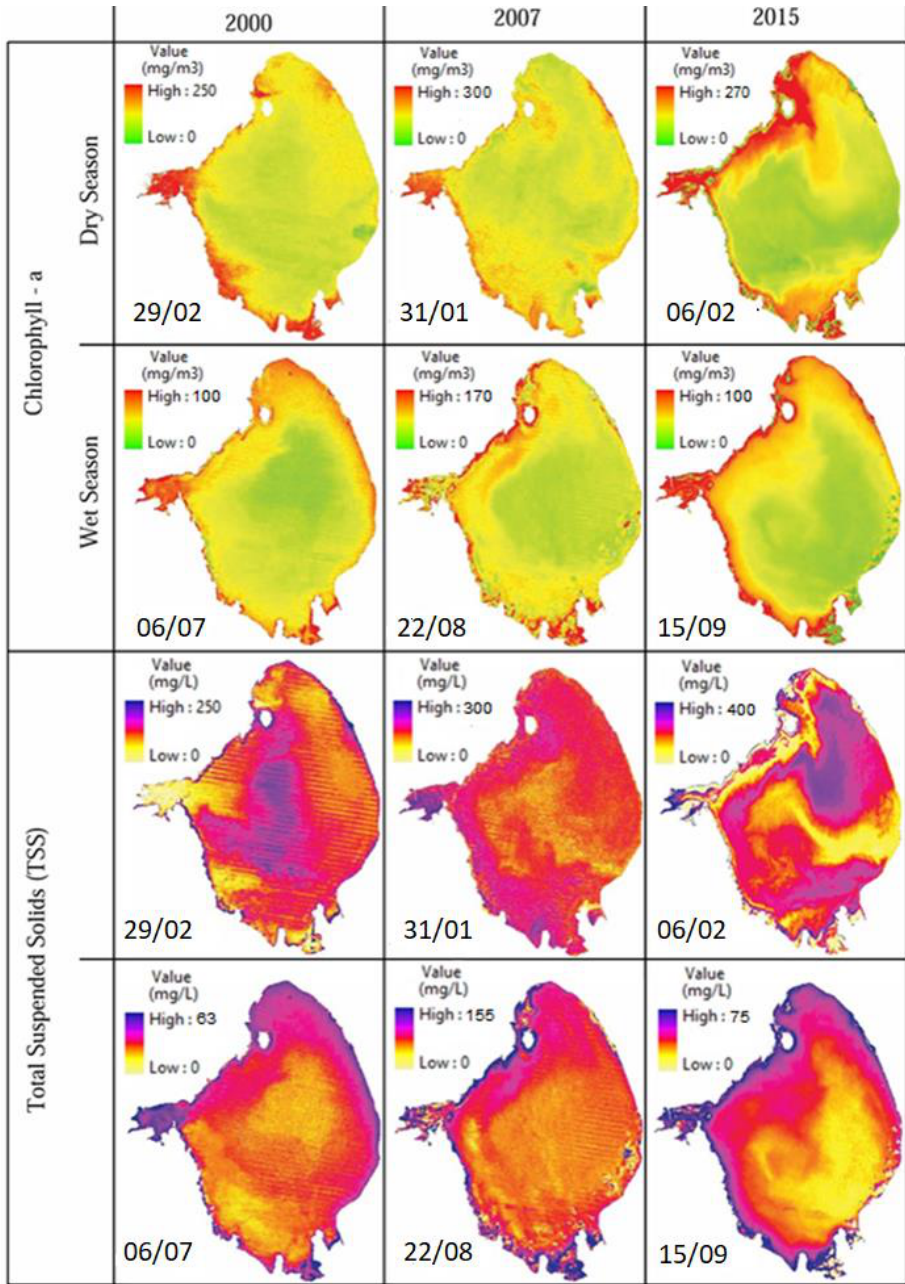
Figure 2. Predicted seasonal and spatial chl-a and TSS values in Lake Okeechobee.